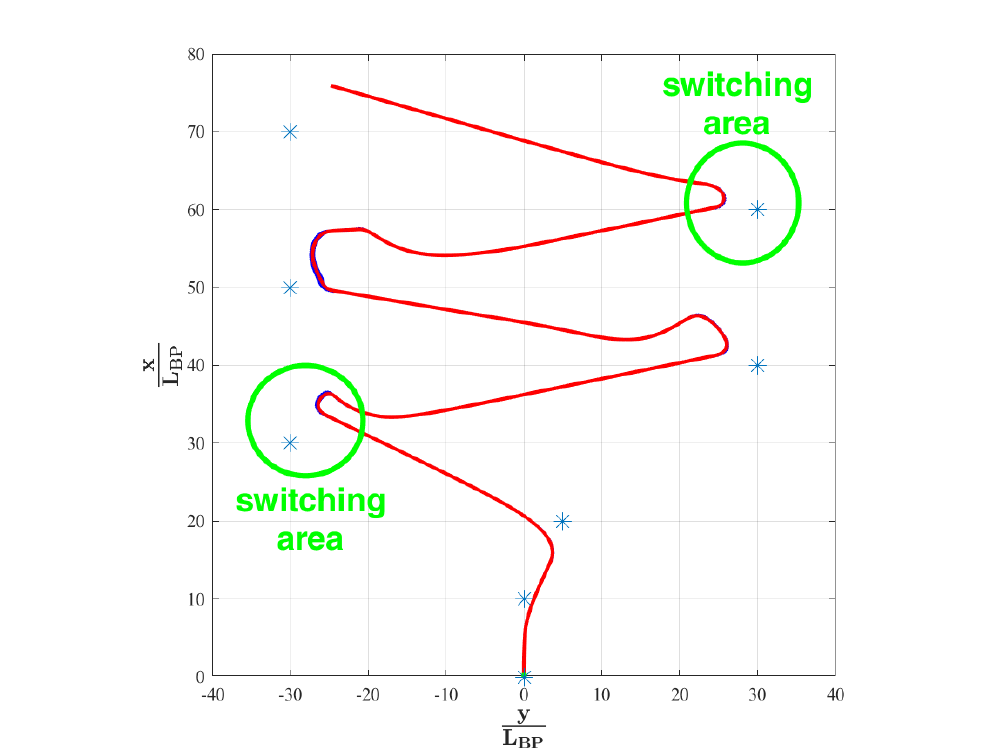
Figure 4. Trajectory obtained by autopilot and free-drift track. Blue markers are the waypoints, red line is the vessel path and green circles represent the switching